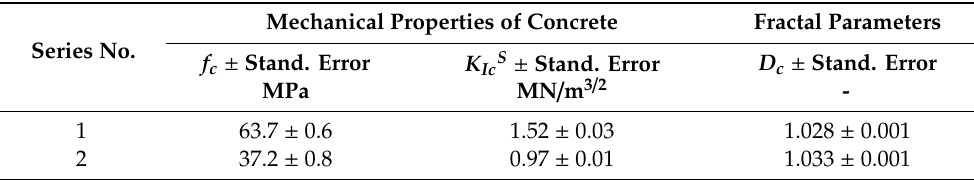
Table 2. Results of tests on compressive strength f c and critical stress intensity factor K IcS after 28 days curing of concrete and results of the fractal analyses.